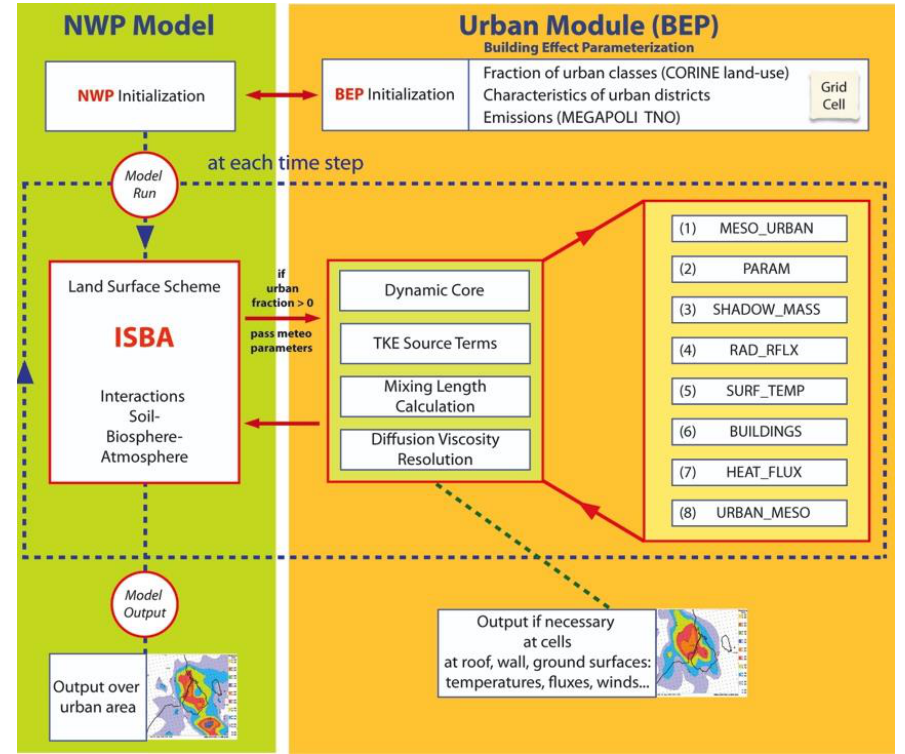
Figure 4. General scheme of the building effect parameterisation (BEP) module for the Enviro-HIRLAM model urbanisation with a structure of the sub-routine conception (adapted from Mahura et al.,